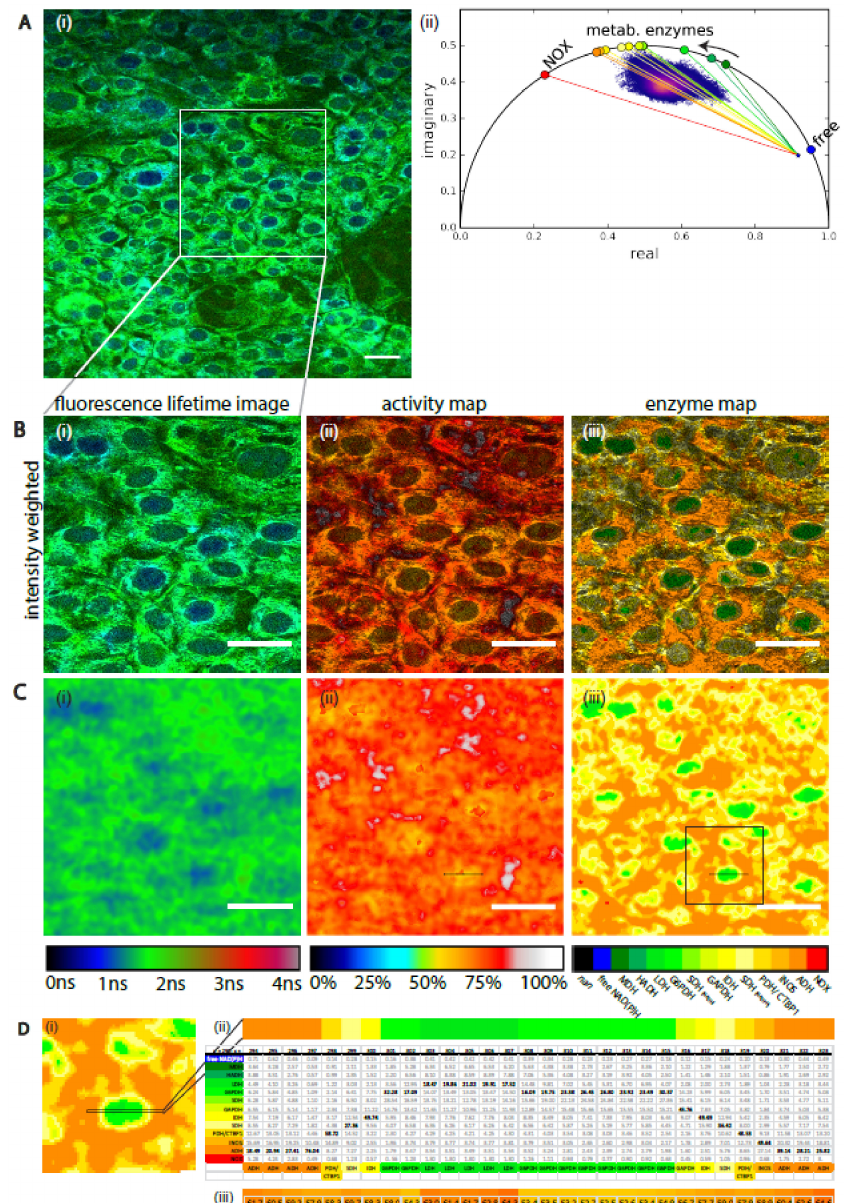
Figure 4. Label-free NAD(P)H-FLIM reveals subcellular heterogeneity of enzyme activity but homogeneous metabolic activity in stromal-like 3T3-L1 cells. ( A ) Spatial-resolved fluorescence